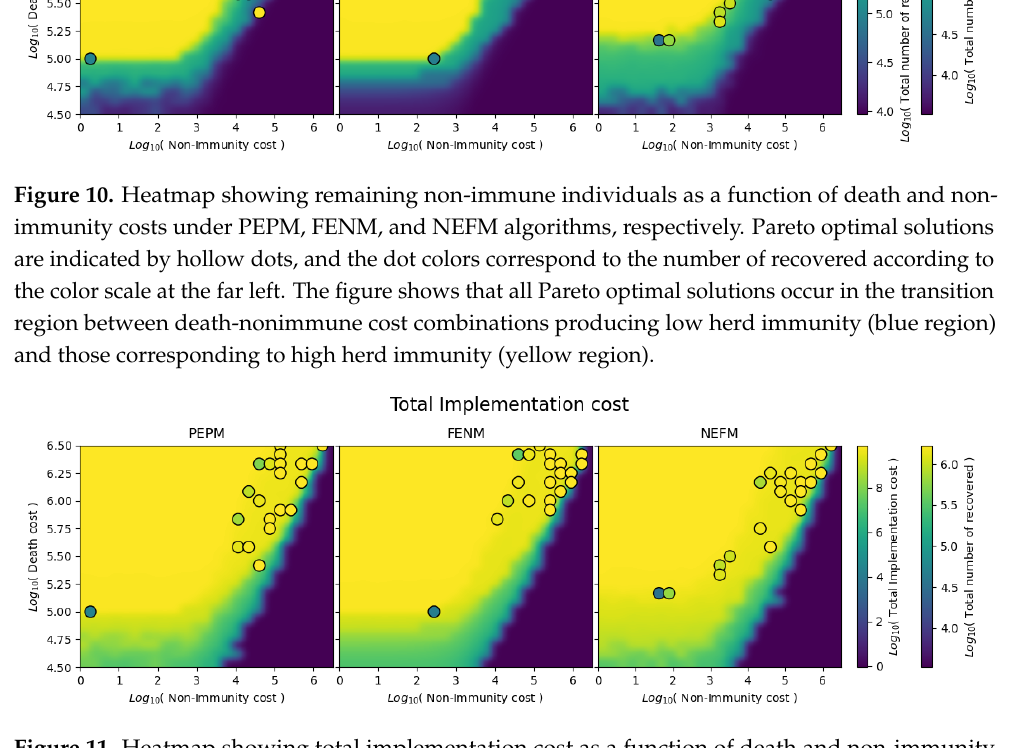
Figure 11. Heatmap showing total implementation cost as a function of death and non-immunity costs under PEPM, FENM, and NEFM algorithms, respectively. Pareto optimal solutions are indicated by hollow dots, and the dot colors correspond to number of recovered according to the color scale at the far